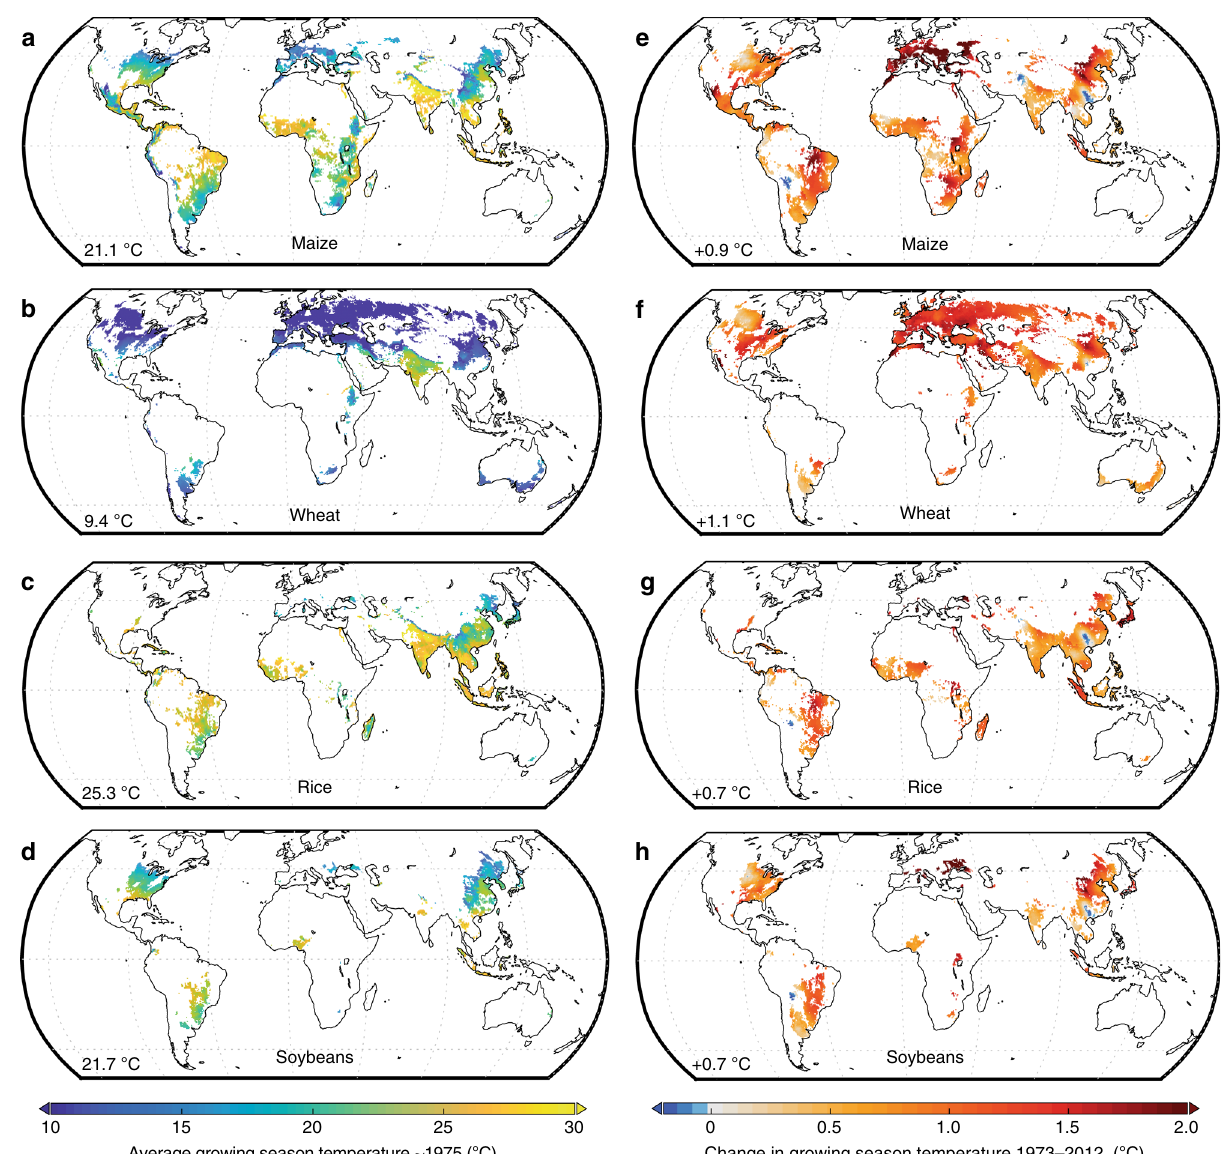
Fig. 2 Growing season temperatures and temperature trends. Average growing season temperatures ( a – d ) have increased from 1973 – 2012 ( e – h ) across most growing areas for maize, wheat, rice, and soybeans. Average growing season temperatures are shown (left) for the beginning of the time period (circa 1975) by averaging the growing season temperatures from 1973 to 1977. Trends are calculated using linear regression, and all values are displayed across the top 98% of average rainfed harvested areas. Temperatures are averaged across multiple growing seasons (e.g., spring and winter wheat) where relevant. The lower left corner of each map shows the globally averaged temperature (left) or change (right), weighted by average rainfed harvested